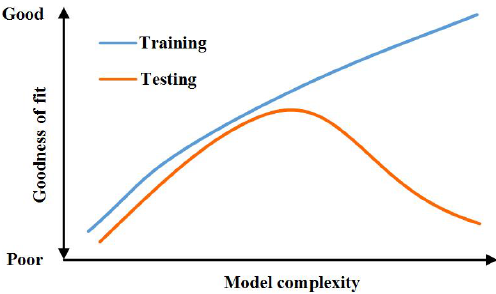
Figure 1. Relationship between the model complexity and the good- ness of fit of a data-driven